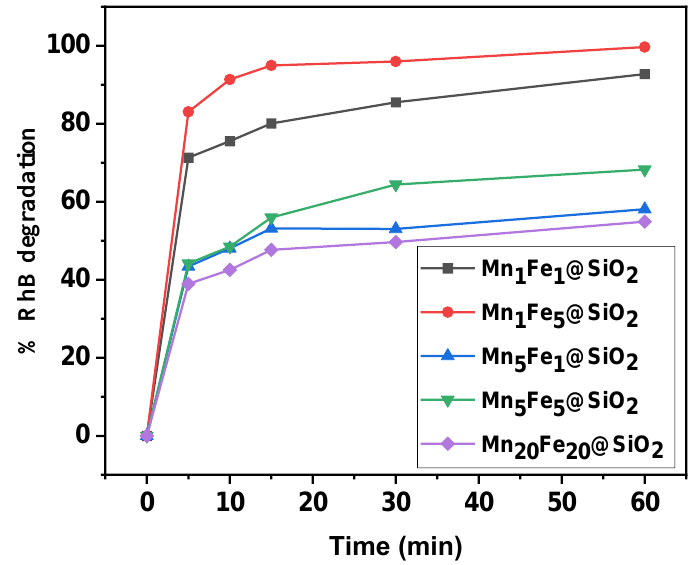
Figure 9. Comparison of synthesized nanocomposites for photocatalytic Fenton-like degradation of RhB.